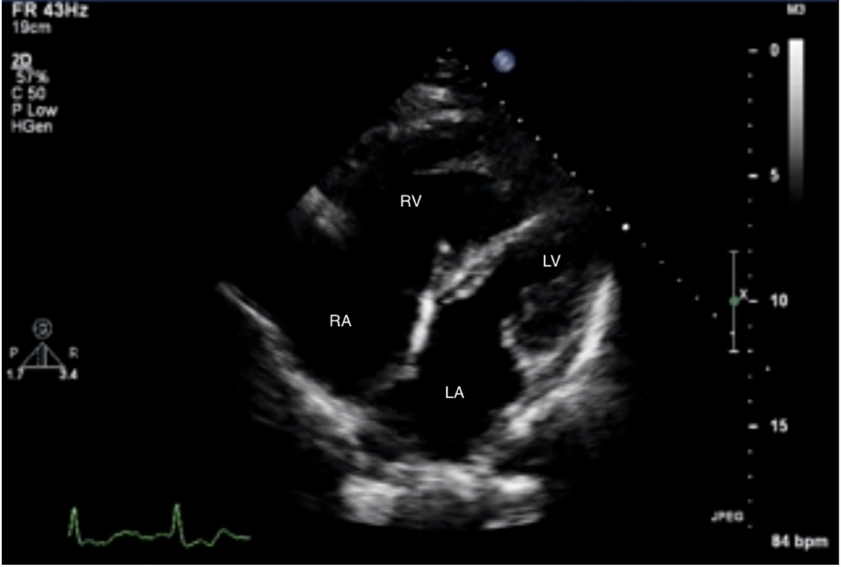
Figure 3. Enlarged right ventricle and right atrium. An abnormal size ratio between the right and left heart. 2D-TTE, 4CH view. 2D-TTE: two-dimensional transthoracic echocardiography; 4CH: four-chamber.